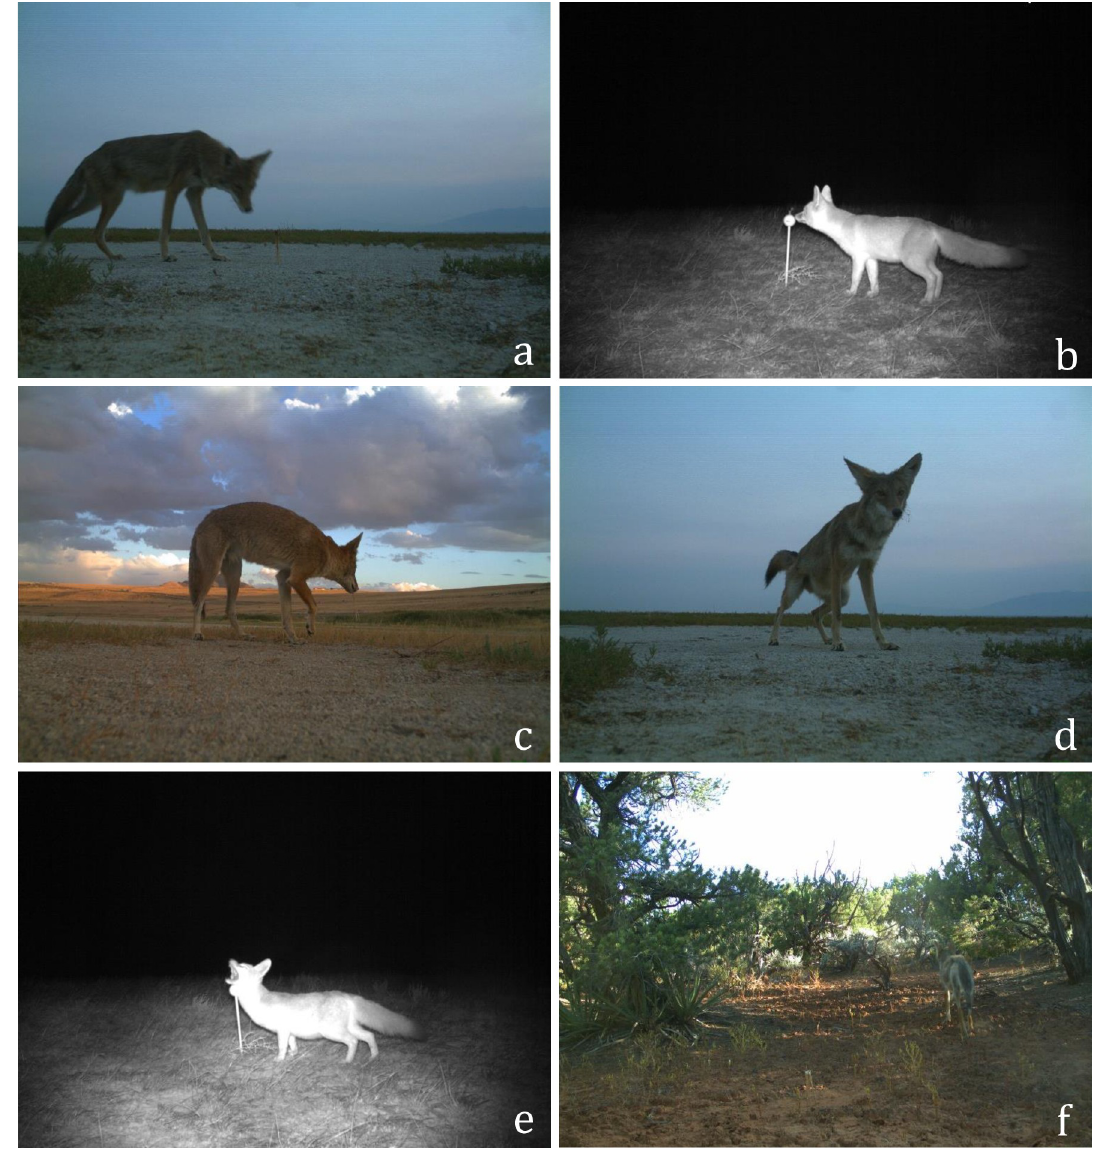
Fig 2. Ethogram of behaviors investigated in this study. From top left to bottom right, panel A shows a coyote approaching the lure; in panel B, a kit fox is sniffing the lure; panel C shows a coyote biting the lure; in panel D, a coyote is urinating on the lure; in panel E, a kit fox is rubbing against the object. Panels A-E are examples of the different behaviors categorized as investigative. In panel F, a coyote is near the lure but not interacting with it (classified as